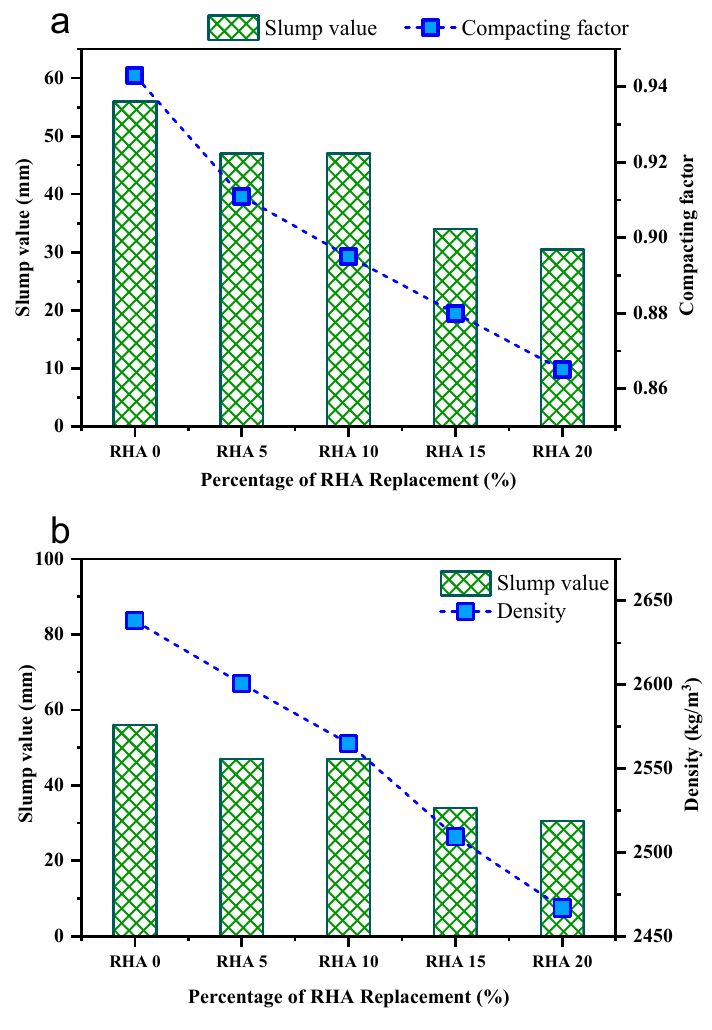
Figure 6. ( a ) Slump values and compacting factor ( b ) variations of slump value and density, with respect to the incorporation of different percentages of RHA.